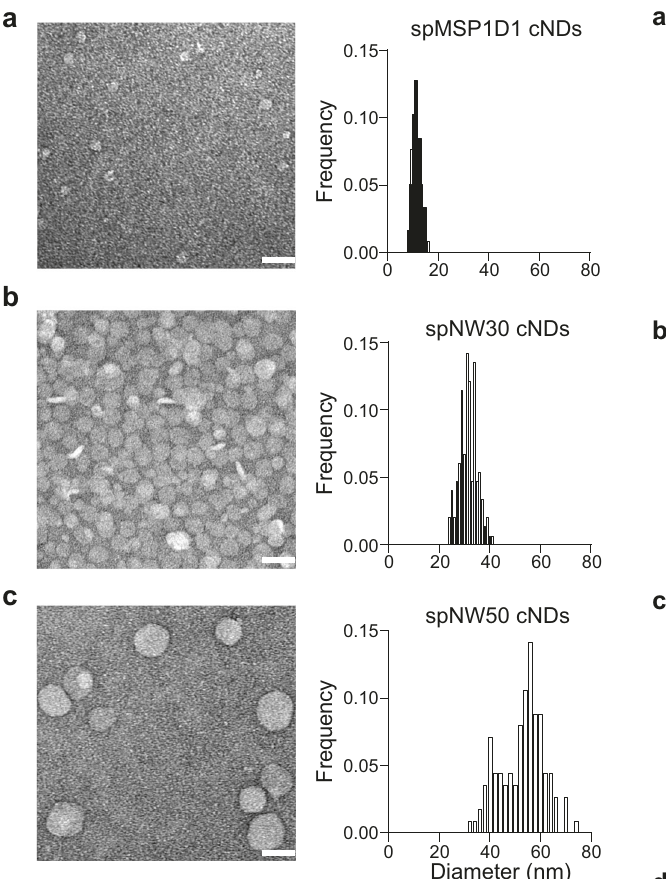
Fig. 3 Characterization of puri fi ed cNDs by negative stain EM. a – c , EM micrographs (left) and size distribution (right) of cNDs made using spMSP1D1 ( a ), spNW30 ( b ), and spNW50 ( c ). n = 117 (spMSP1D1 cNDs), 148 (spNW30 cNDs), 113 (spNW50 cNDs). scale bar, 50 nm. Source Data are available as a source data fi le.